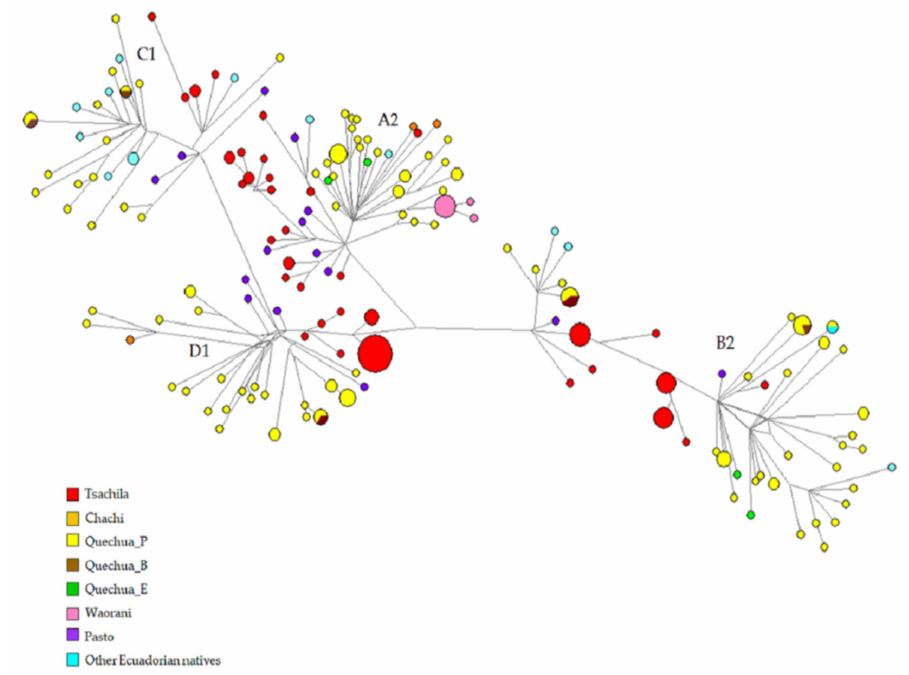
Figure 2. Median joining network for A2, B2, C1, and D1 haplotypes of mtDNA entire genomes ( n = 313) among Peruvian, Bolivian, Colombian, and Ecuadorian populations color-coded by ethnicity/linguistic affiliation. The haplotypes are represented by circles with sizes proportional to the number of individuals and branch lengths proportional to the number of mutational steps. The Quechua populations are divided by country (Peruvian, Bolivian, and Ecuadorian Quechua are indicated by Quechua_P, Quechua_B, and Quechua_E, respectively).